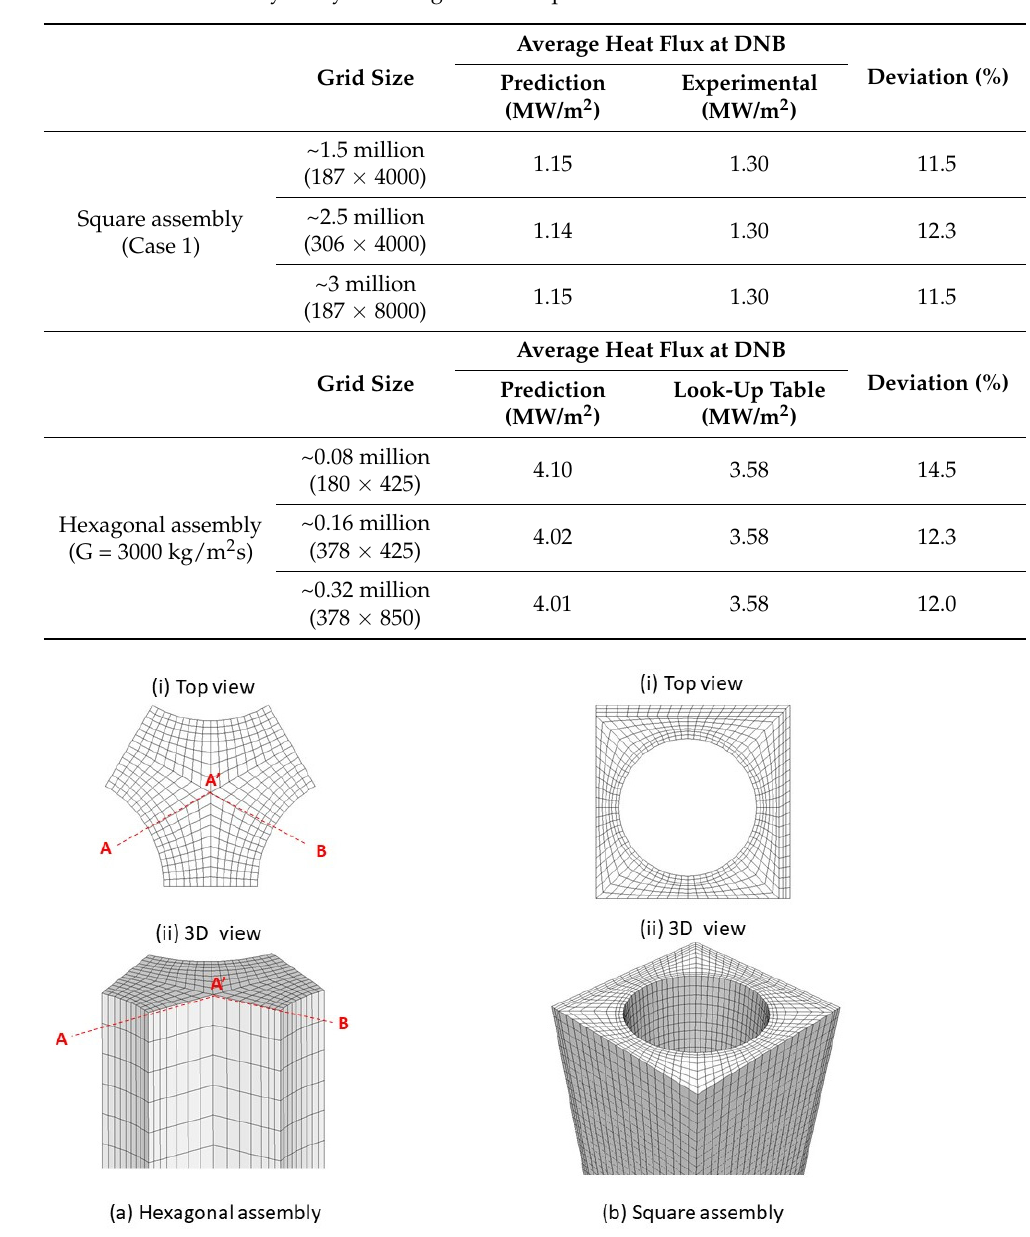
Figure 6. ( a ): ( i ) top view of mesh distribution (0.16 million) in hexagonal assembly, ( ii ) correspond- ing 3D view of mesh distribution in hexagonal assembly. The portion enclosed by planes A–A’ and A’- B corresponding to the top view in ( i ) has been removed in ( ii ) to show the internal mesh distribution. ( b ): ( i ) top view of mesh distribution in square assembly (2.5 million), ( ii ) corresponding 3D view of mesh distribution in square assembly.